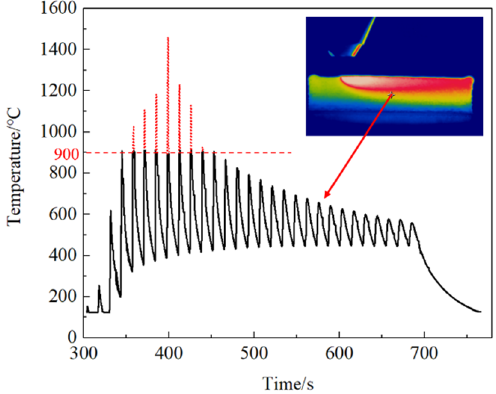
Figure 8. A point’s time-temperature history recorded by the infrared thermal imager.